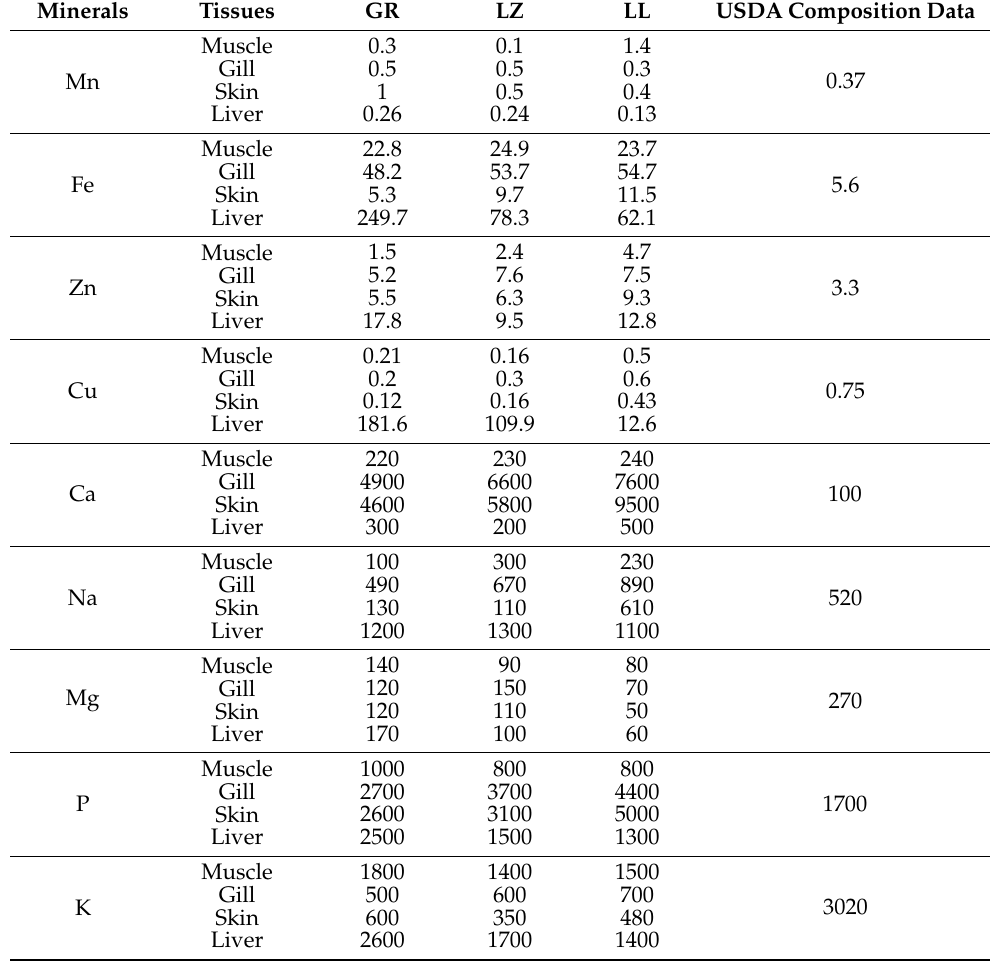
Table 6. Comparison of mineral concentrations (mg/100 g DW) of Nile tilapia tissues from three Ethiopian lakes with USDA compositional data for raw tilapia